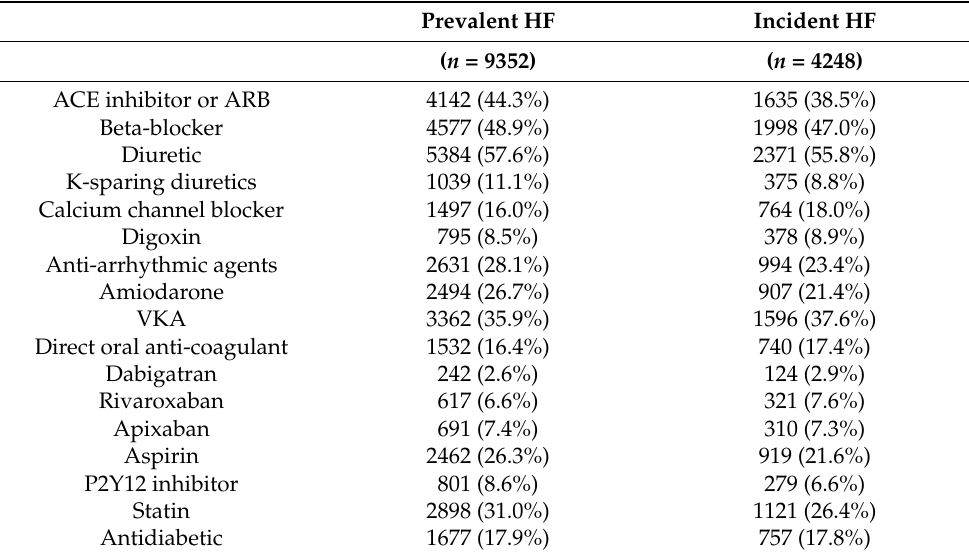
Table 2. Rate of medication at discharge for patients with AF and HF (at the time of hospitalization with the last event between AF or